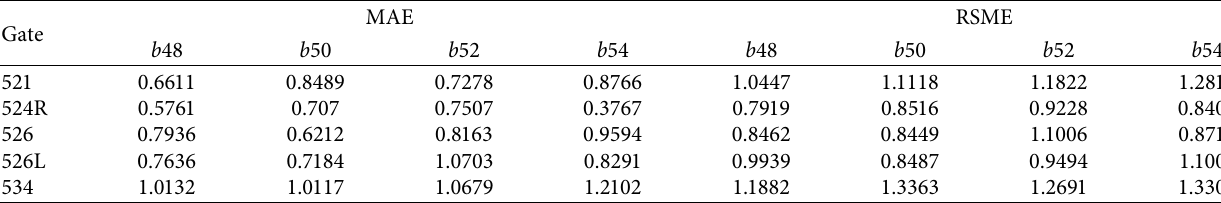
Table 7: Error index of OD